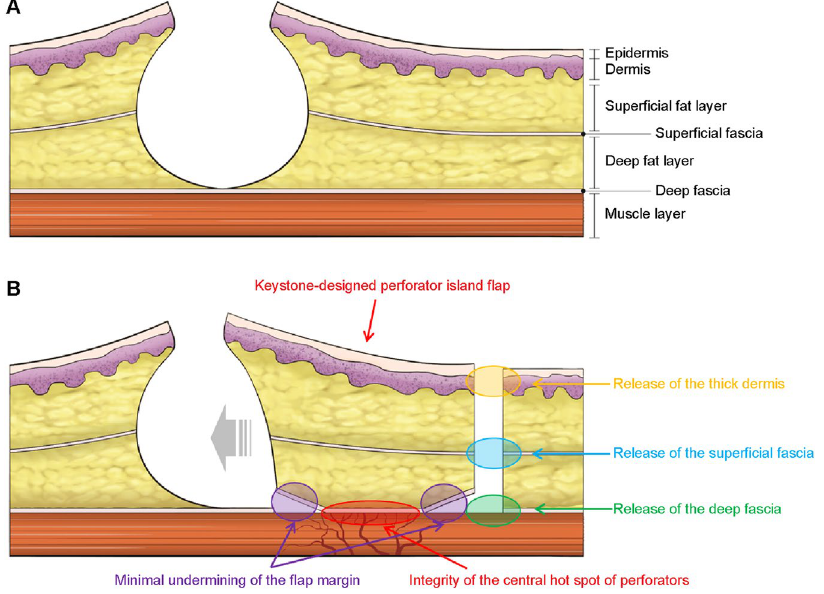
Figure 6. Schematic diagram of the keystone-design perforator island flap (KDPIF) movement. ( A ) Cross- sectional diagram after complete excision of the complicated epidermoid cyst (EC). ( B ) The KDPIF movement on the back is provoked by three main factors. The first factor (orange-coloured oval) is the release of the thick dermis of back; the second (blue-coloured oval) is the release of the superficial fascia; and the last (green- coloured oval) is the release of the deep fascia. Then, minimal flap undermining of the flap margin (purple- coloured circle) is performed to preserve the integrity of the ‘central hot spot’ of perforators (red-coloured